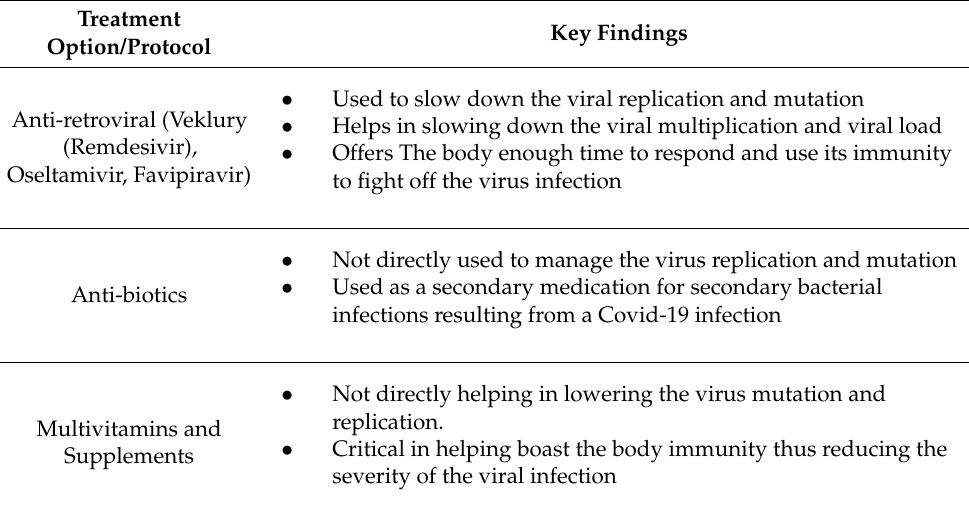
Table 1. Findings